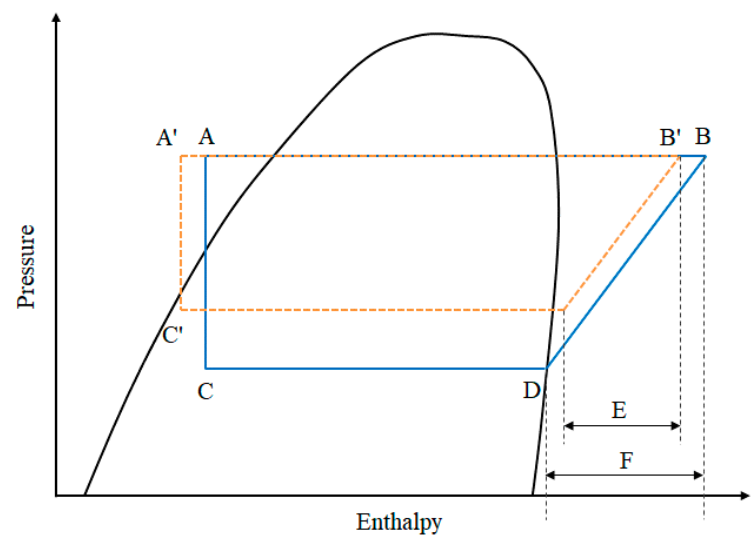
Figure 5. P-h diagram of heating operation.